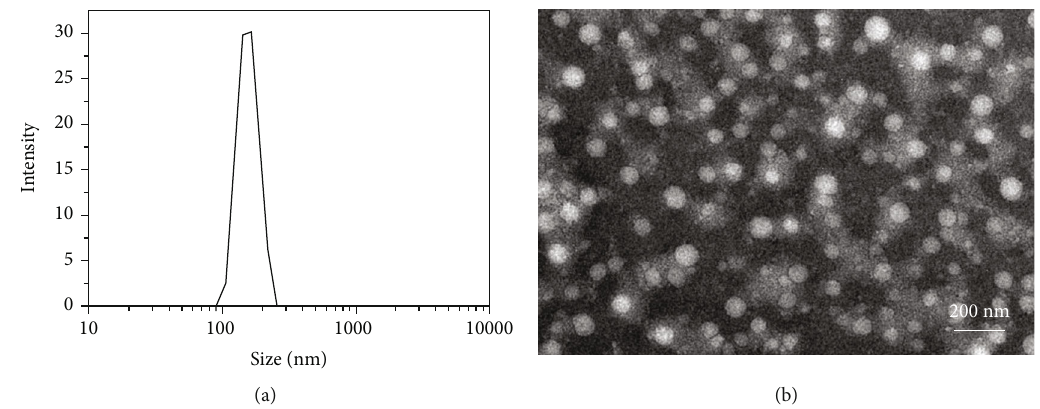
Figure 3: Size distributions of TRM measured by DLS (a) and the TEM image of TRM (b). Scale bar was